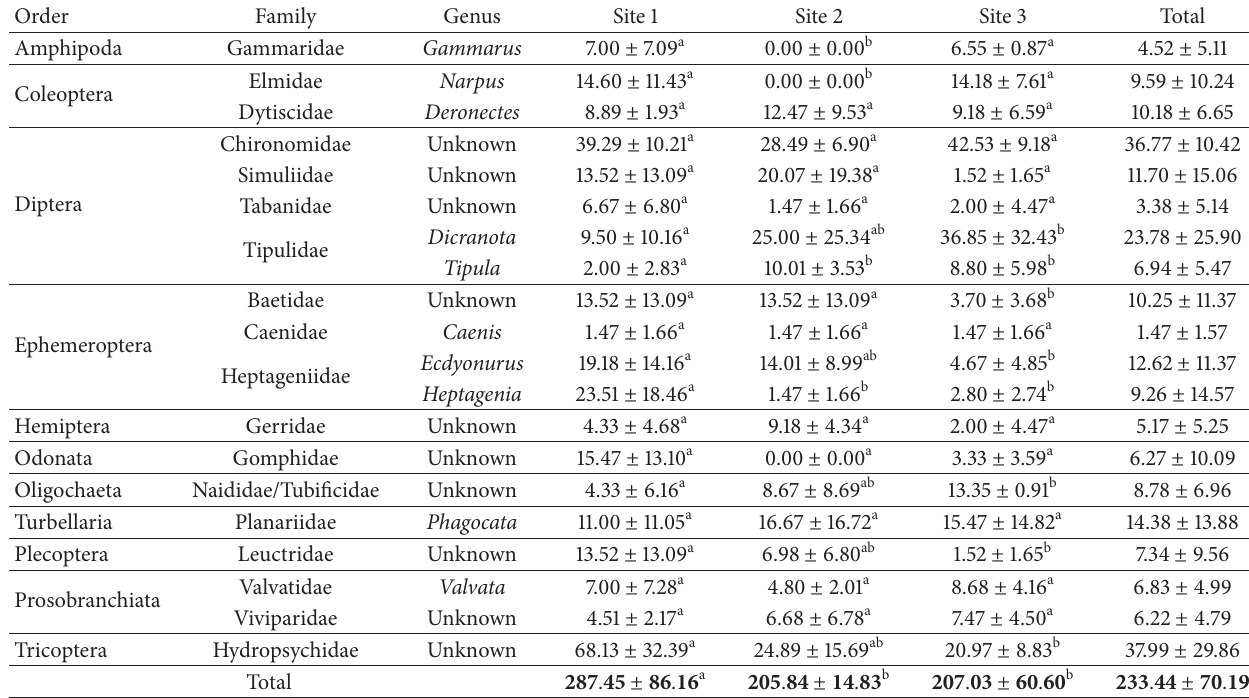
Table 2: Taxonomic composition and mean values ± standard Deviation of abundance (individual/m 2 ) of the benthic macroinvertebrates.